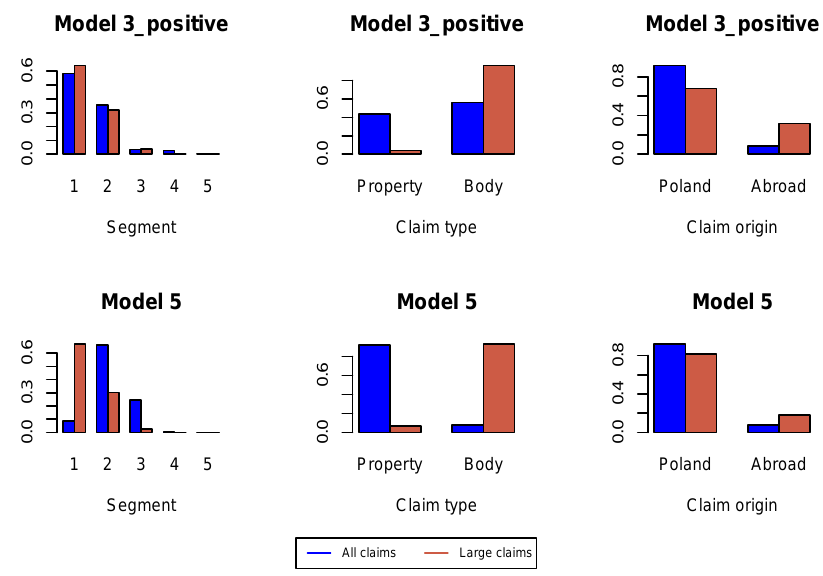
Figure A10. Proportions of claim features in the whole data set and in the data set of large claims in k = 16.